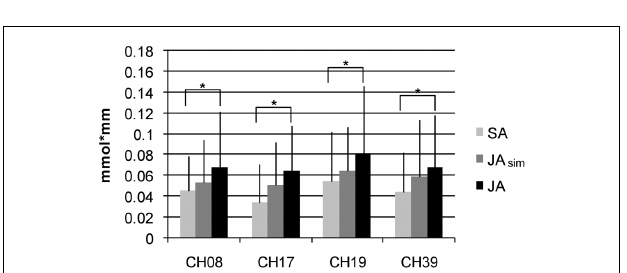
FIGURE 4 | Mean values (activation phase – baseline) with SD for [oxy-Hb] over all subjects for the four channels in the IPL which show the properties of action simulation areas. Displayed are the conditions SA, JA sim , and